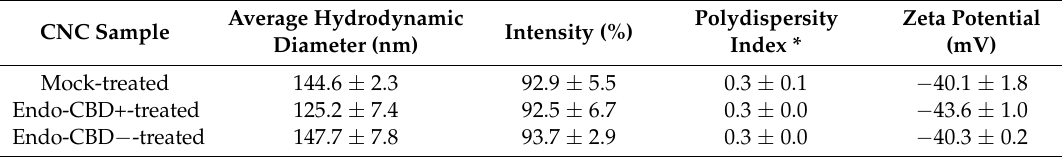
Table 2. Dynamic light scattering (DLS) analysis for particles size and zeta potential (ZP) measurements of CNCs extracted from untreated and endoglucanase-treated (1.0 U/g of pulp loading) wood